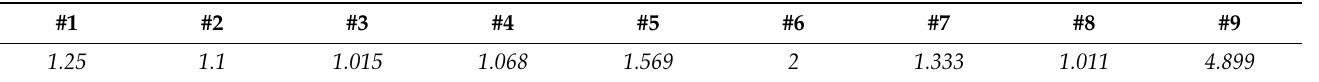
Table 1. Split ratio (potential trading number of shares after the split exchanged for each single share before the split) for the nine examined